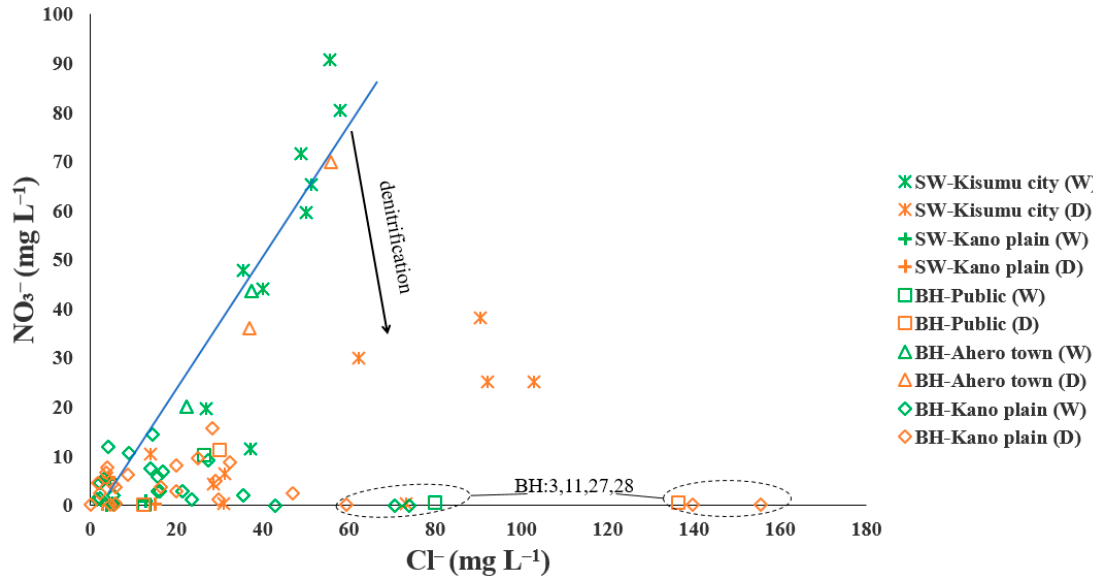
Figure 6. Cl − vs. NO 3 − concentrations of groundwater samples. SW-Kisumu city: shallow wells located in Kisumu city; SW-Kano plain: shallow wells in Kano plain; BH-Ahero town: boreholes in Ahero town; BH-Public: boreholes in public institutions located in populated neighborhoods; and BH-Kano plain: boreholes in Kano plain, during wet (green symbols) and dry (brown symbols) seasons, for determination of NO 3 − removal mechanisms. Blue line is the dilution line, while the black arrow indicates samples undergoing NO 3 − removal through denitrification.